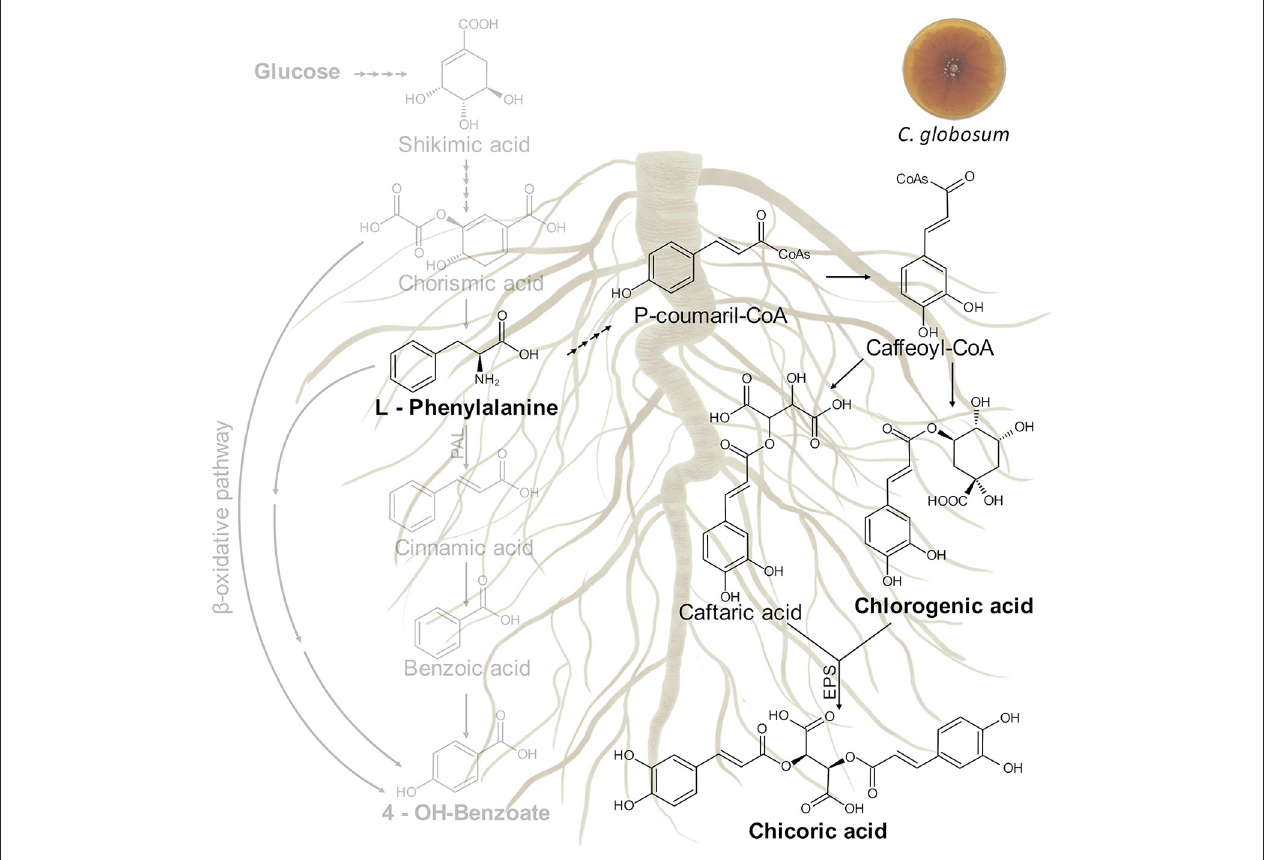
FIGURE 9 | Putative metabolic pathway involved in chicoric acid biosynthesis in C. intybus roots. In bold are reported the identified metabolites. EPS: acyltransferase.